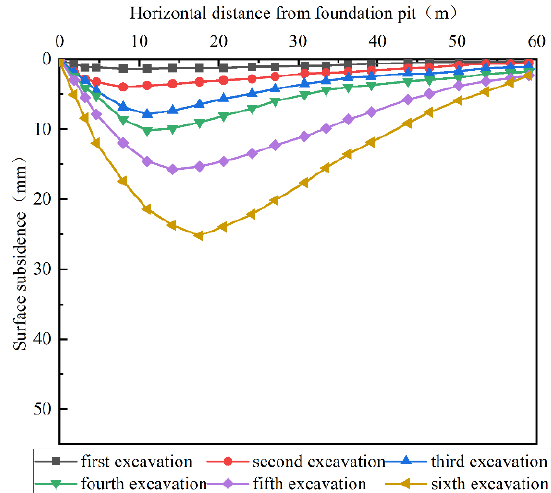
Figure 25. Surface settlement curve during foundation pit excavation with a 0.001 m-wide seepage point.